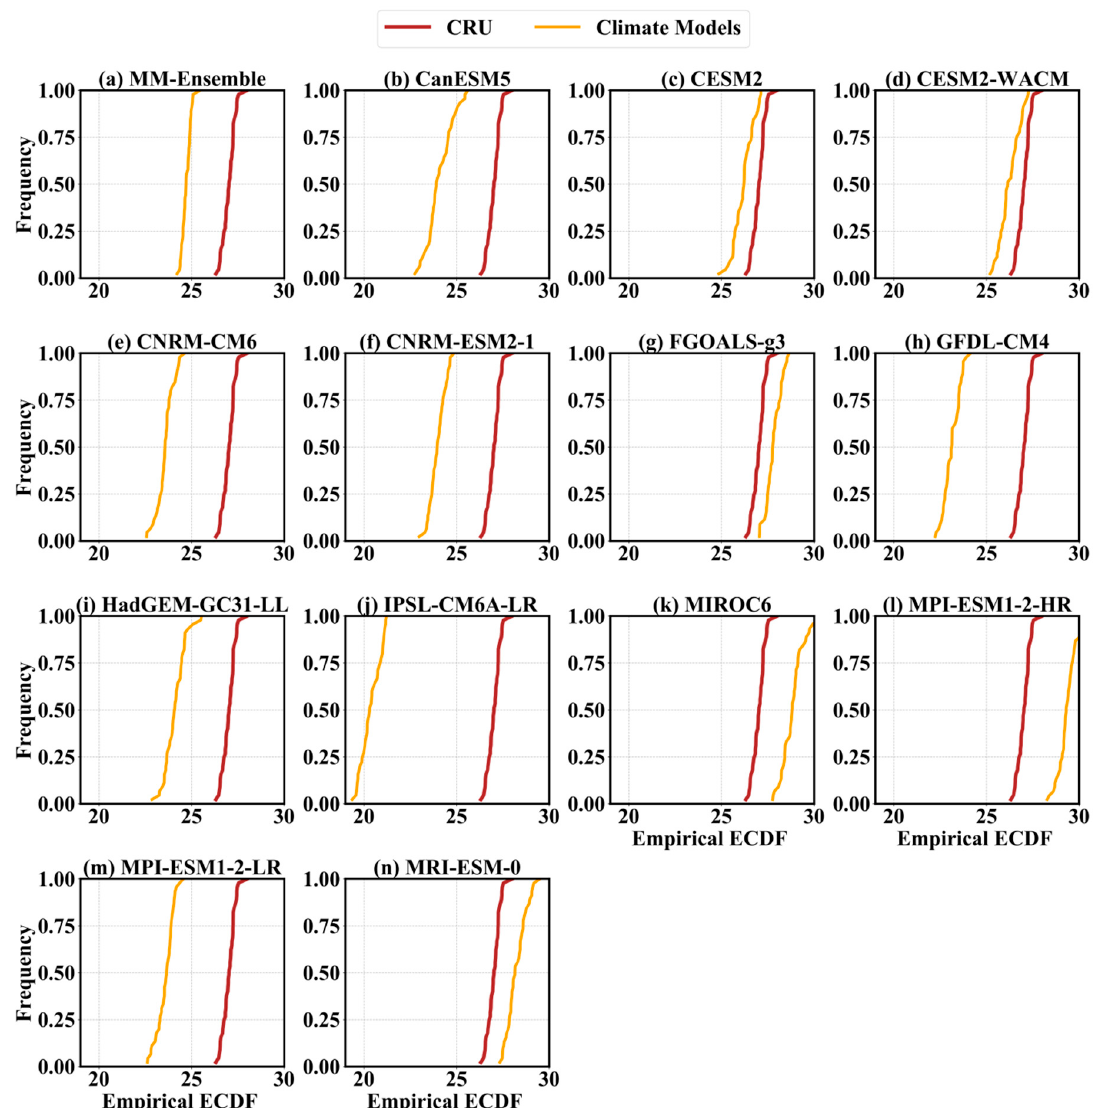
Figure 5. JJA months cumulative distribution frequency (°C/month) from observed (CRU) versus ( a ) MM-Ensemble, ( b ) Can-ESM5, ( c ) CESM2, ( d ) CESM-WACCM, ( e ) CNRM-CM6-1, ( f ) CNRM-ESM2-1, ( g ) FGOALS-g3, ( h ) GFDL-CM4, ( i ) HadGEM-GC31-LL, ( j ) IPSL-CM6A-LR, ( k ) MIROC6, ( l ) MPI-ESM1-2-HR, ( m ) MPI-ESM-2-LR, and ( n ) MRI-ESM-0 models. Red-colored line shows CRU observed ECDF and yellow lines show empirical cumulative distribution frequency (ECDF) for individual models under study and their ensemble. The x-axis shows temperature range (°C) and the y-axis shows its frequency f(x).